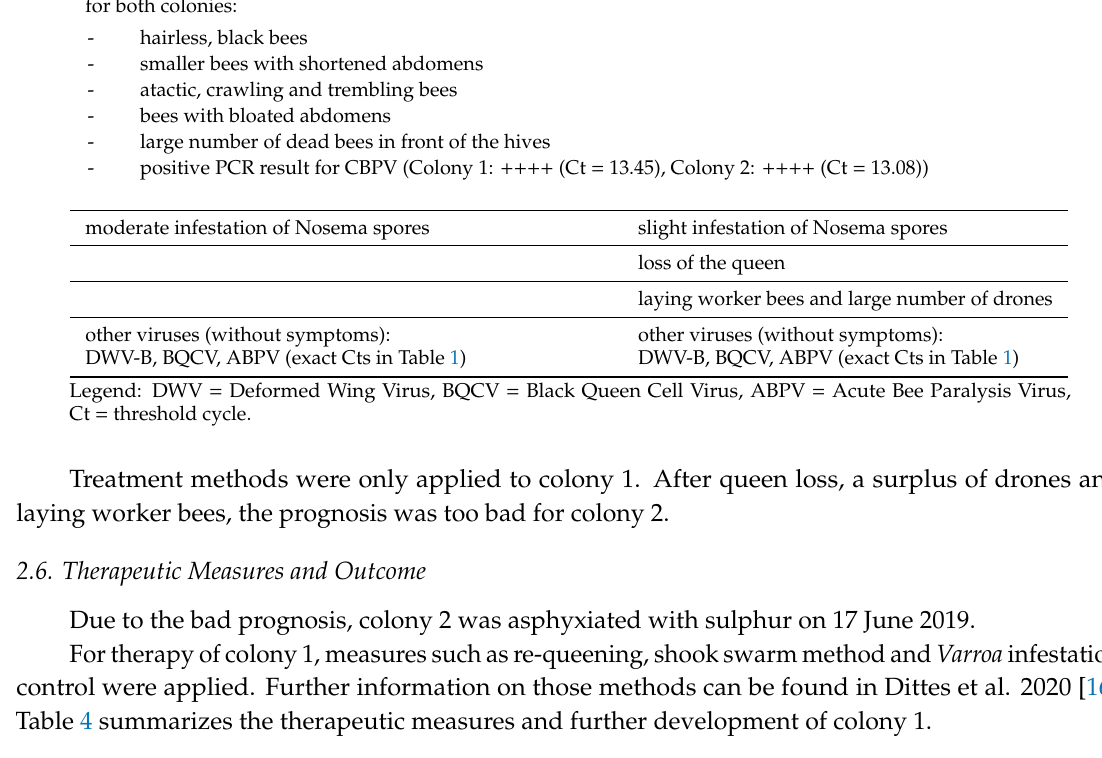
(CBPV) in Table 3. List of medical issues in two honey bee colonies infected with Chronic Bee Paralysis Virus (CBPV) in 2019.